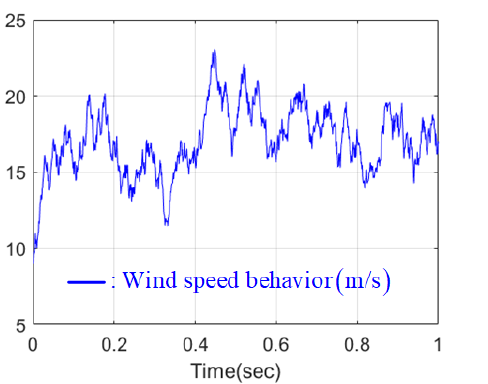
Figure 2. Wind speed behavior from Weibull distribution-based wind model.